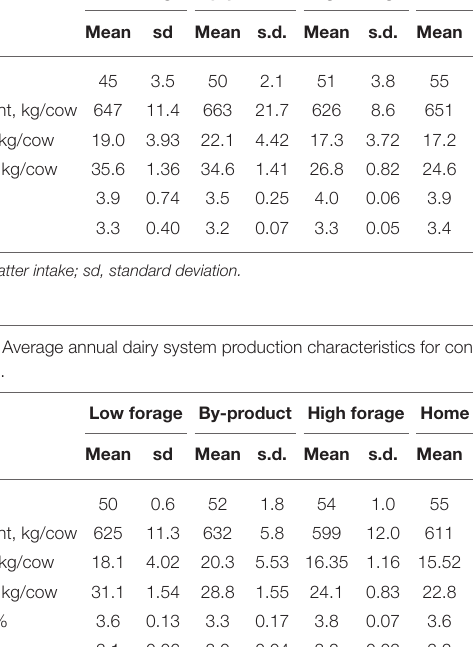
TABLE 4 | GHG emissions and land use factors applied to dairy system purchased feed components.